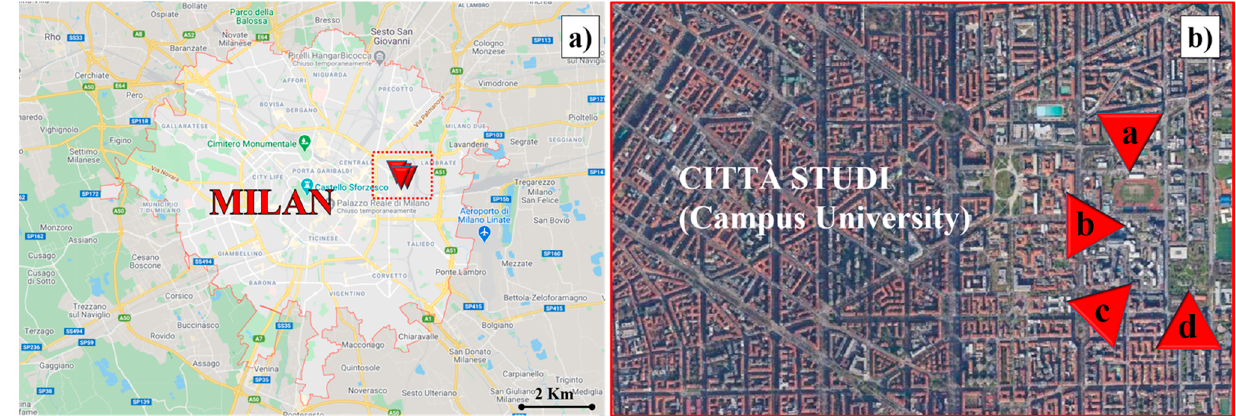
Figure 2. The investigated area in Milan ( a ) with the indications of the sampling sites ( b ); in this case a represents ARPA station; b the Bioscience Department; c the Chemistry Department and d the Botanical Garden.